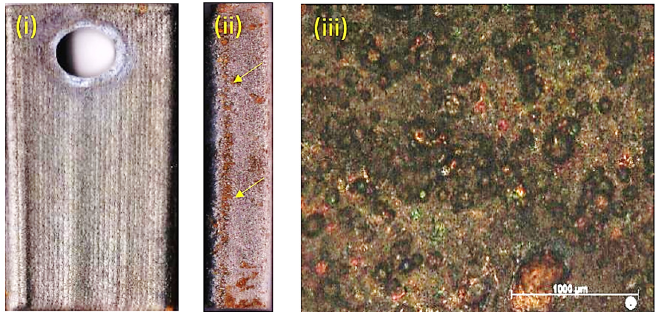
Figure 4. Mo-HEA-S235JR sample after the exposure in the wellhead test: ( i ) front face with negli- gible erosion damage observed, ( ii ) cross-section of the sample showing curvature and iron-based corrosion products in the coating-substrate interface, and ( iii ) magnified surface of the front face showing sphere-like unfused Mo-HEA powder on the surface. The galvanic sample was not observed in the other two samples, Mo-HEA-316L and